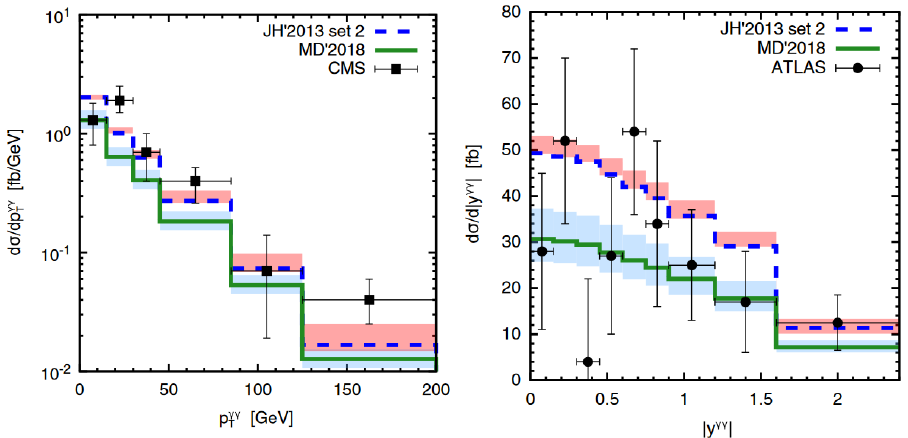
Figure 6. The differential cross sections of inclusive Higgs boson production (in the diphoton √ decay mode) at s = 13 TeV as functions of diphoton pair transverse momentum p γγ rapidity | y γγ | . Notation of the histograms is the same as in Fig. 1. The experimental data are from CMS [25] and ATLAS